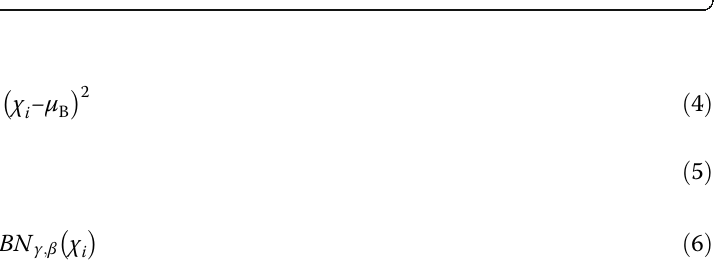
Fig. 1 Structure diagram of the Inception-v3